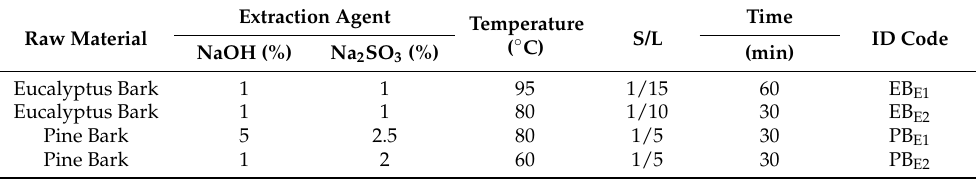
Table 1. Extraction conditions on extraction